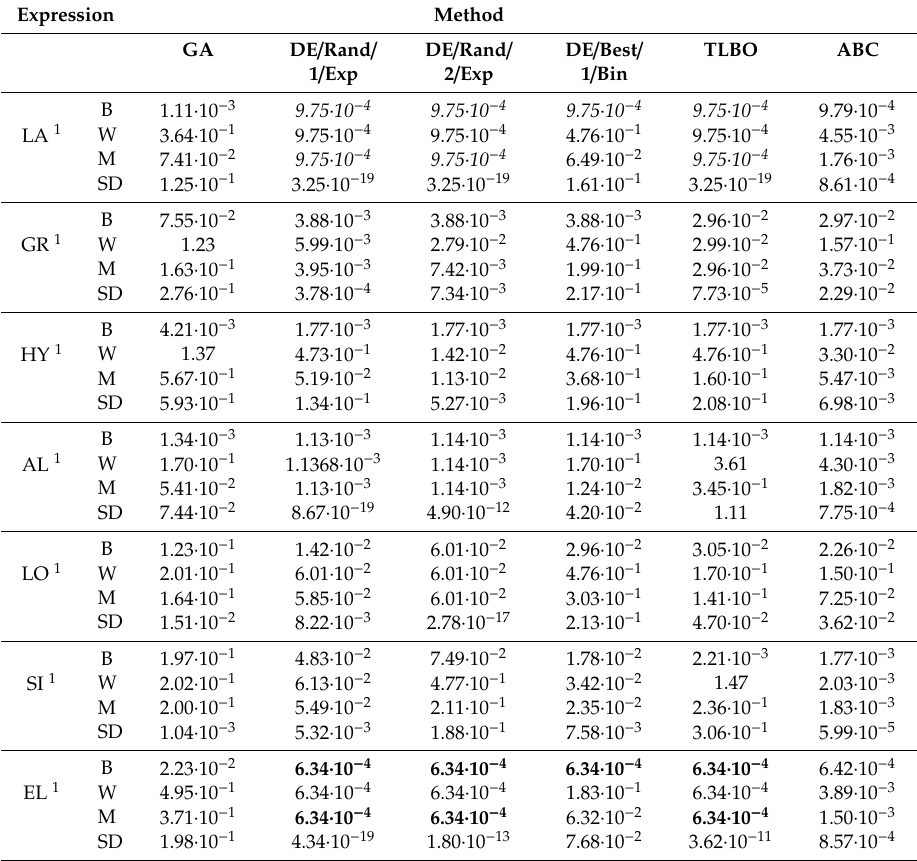
Table 2. Best (B), worst (W), mean (M) and standard deviation (SD) for 30 independent runs of di ff erent methods using expressions (1) to (7) for SML.